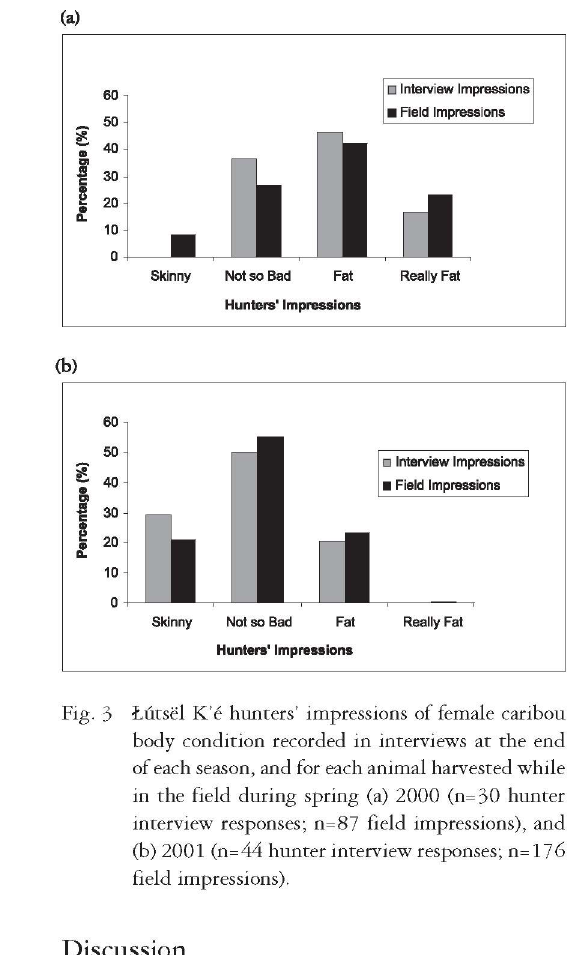
Fig. 3 iutsel K'e hunters' impressions of female caribou body condition recorded in interviews at the end of each season, and for each animal harvested while in the field during spring (a) 2000 (n=30 hunter interview responses; n=87 field impressions), and (b) 2001 (n=44 hunter interview responses; n=176 field